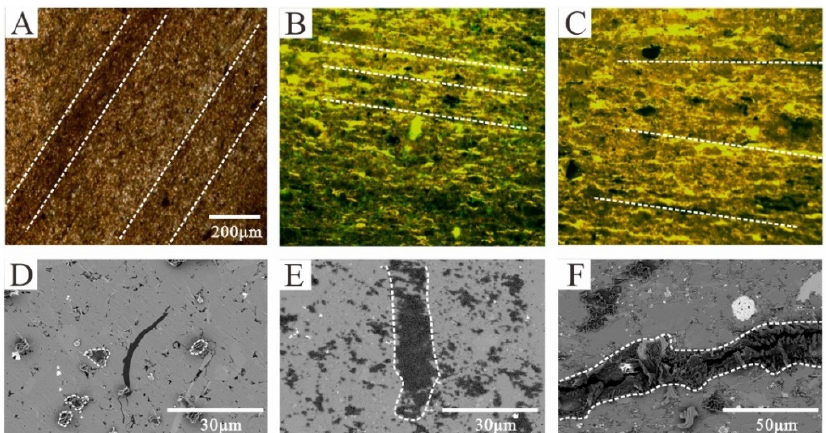
Figure 10. Microscopic characteristics of laminated argillaceous dolomite ( A ) Dolomite lamina well CY1 2682.89 m after [24] ( B , C ) Laminated alginite well C100 2156.9 m 2191.05 m after [25] ( D , E ) Oil molecules fill the pores of dolomite matrix well CY1 after [23] ( F ) Laminar fractures are developed and filled with oil molecules well CY1 after [23] Dotted white lines indicate lamina in ( A – C ) and precipitated oil in ( D , E ).